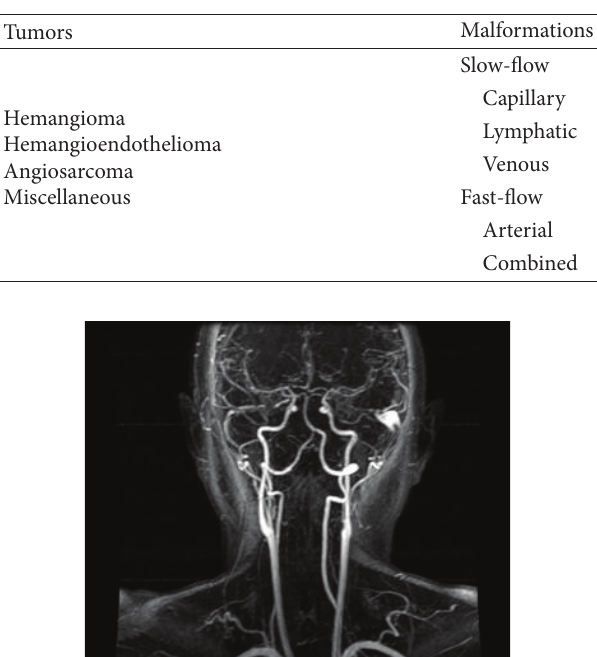
Table 1: ISSVA classification of vascular anomalies.